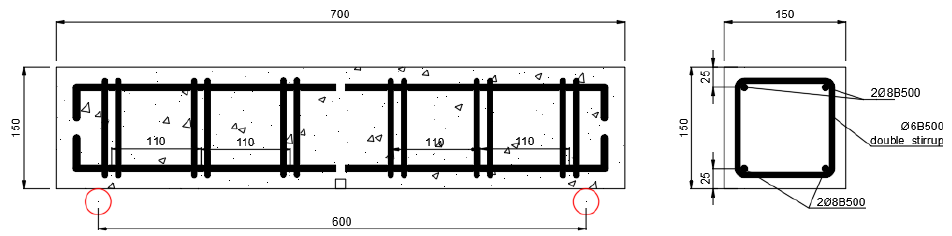
Figure 4. Internal steel reinforcement arrangement.